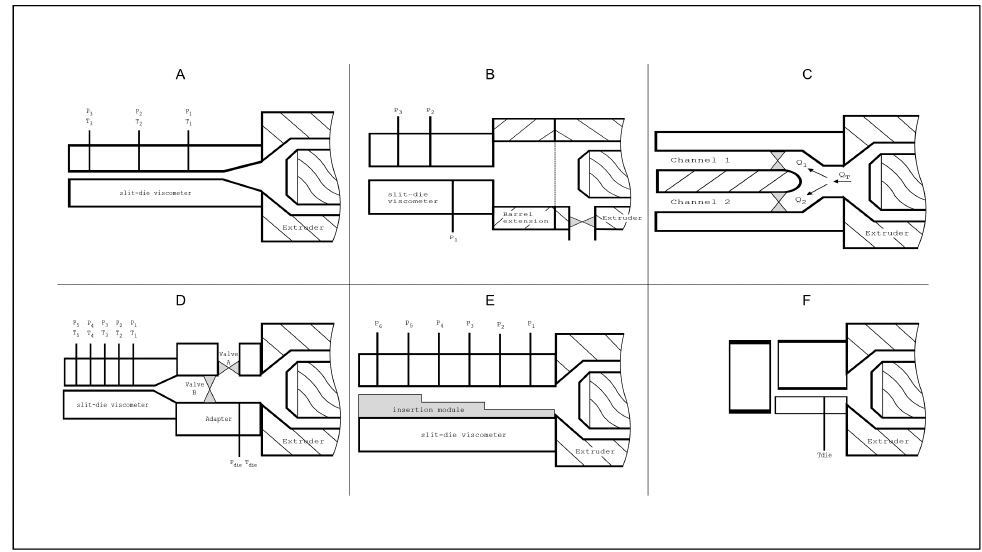
Figure 2. Slit-die viscometer designs. The dimensions are not representative of the original